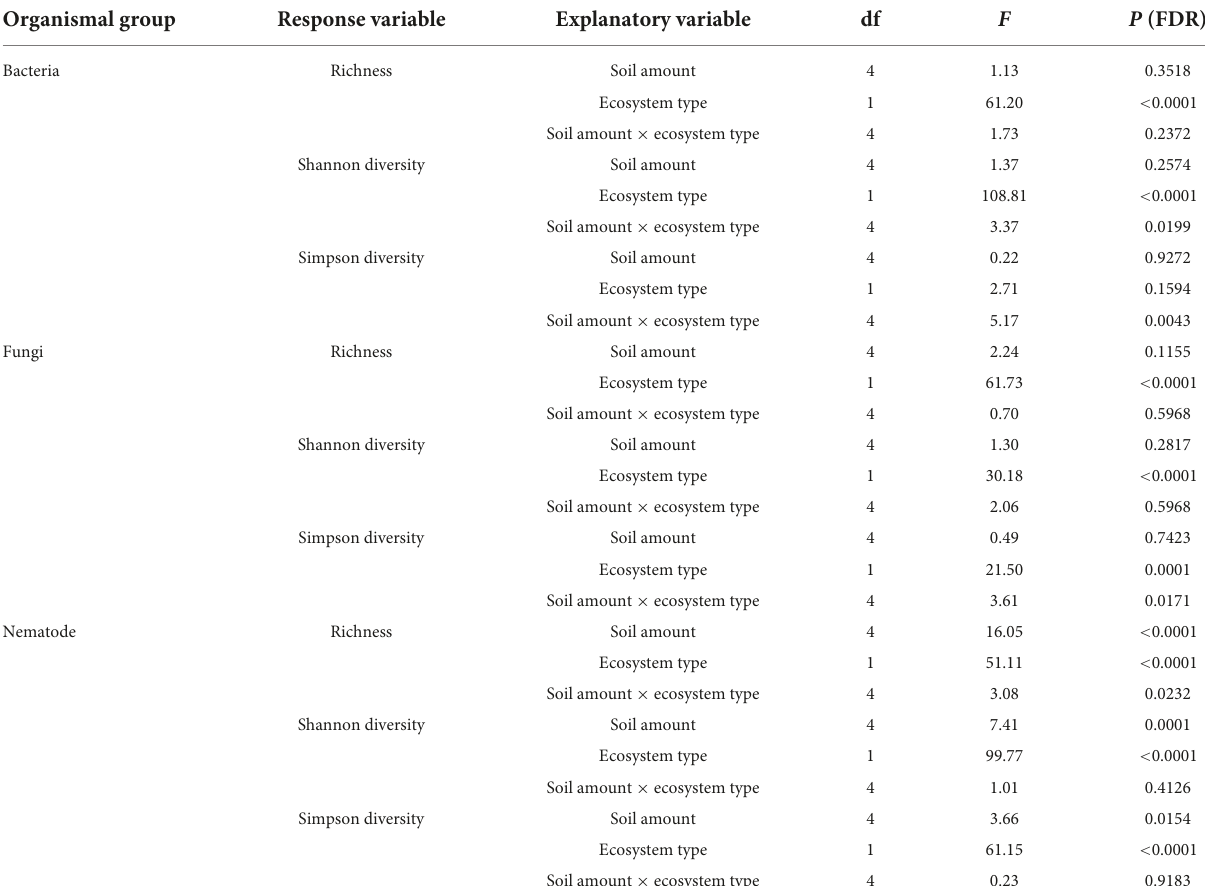
TABLE 1 ANOVA of α